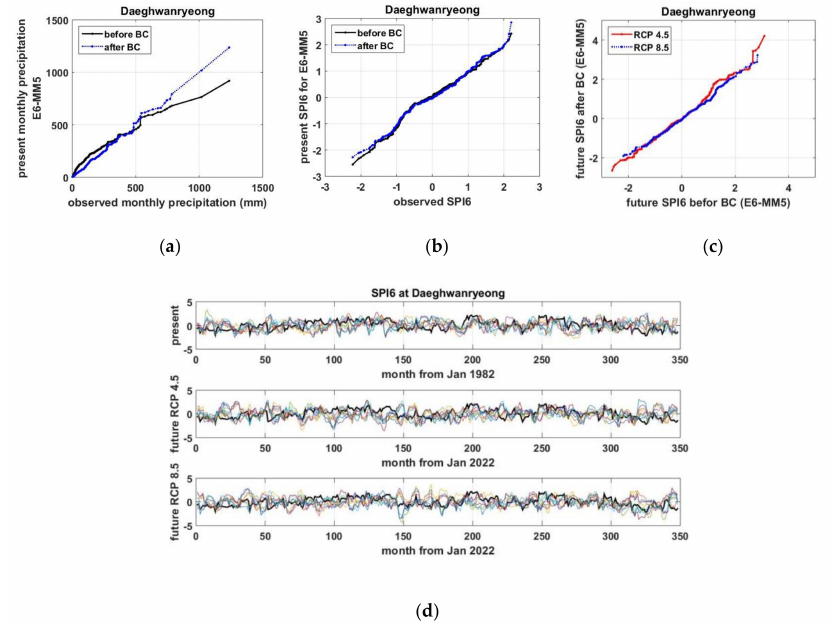
Figure 9. Future SPI6 projection: ( a ) Monthly precipitation; ( b ) Present SPI; ( c ) Future SPI; ( d ) Present and future SPI6 time series ensemble.